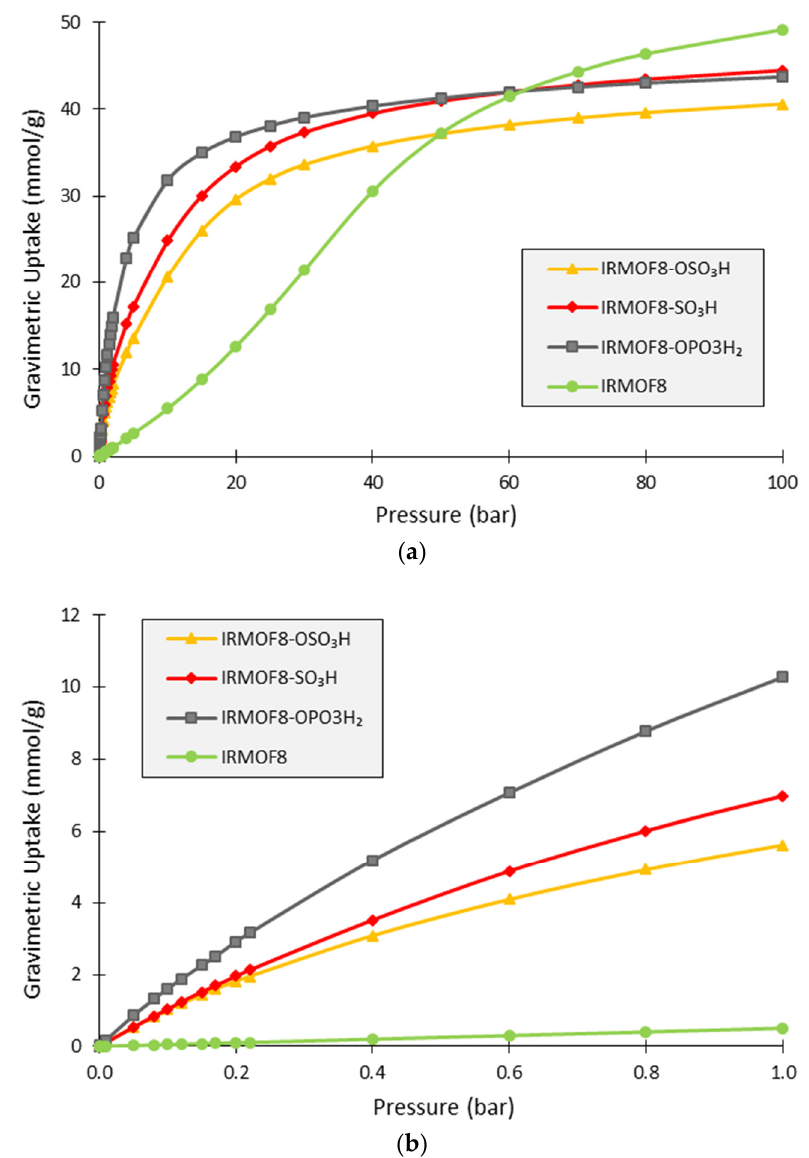
Figure 6. Absolute Gravimetric isotherms for IRMOF8 and IRMOF8-n (n: -OSO 3 H, -SO 3 H, and -OPO 3 H 2 ,) at T = 298 K and pressure range up to ( a ) 100 bar and ( b ) 0.10 bar.